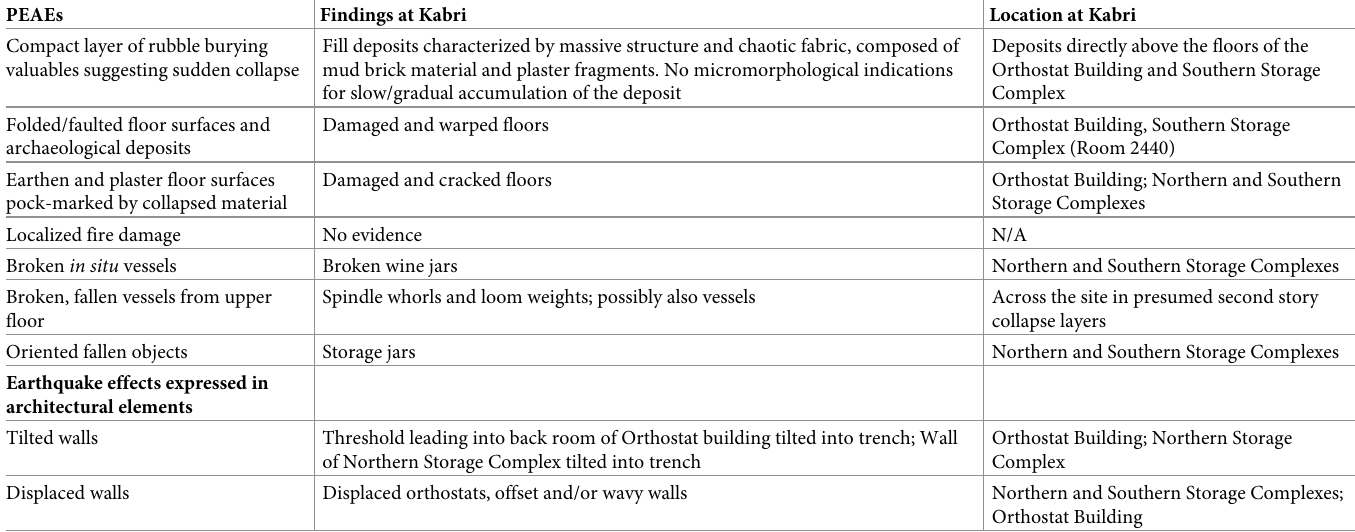
Table 1. Potential (off-fault) Earthquake Archaeological Effects (PEAEs) (after [11]) and corresponding findings in